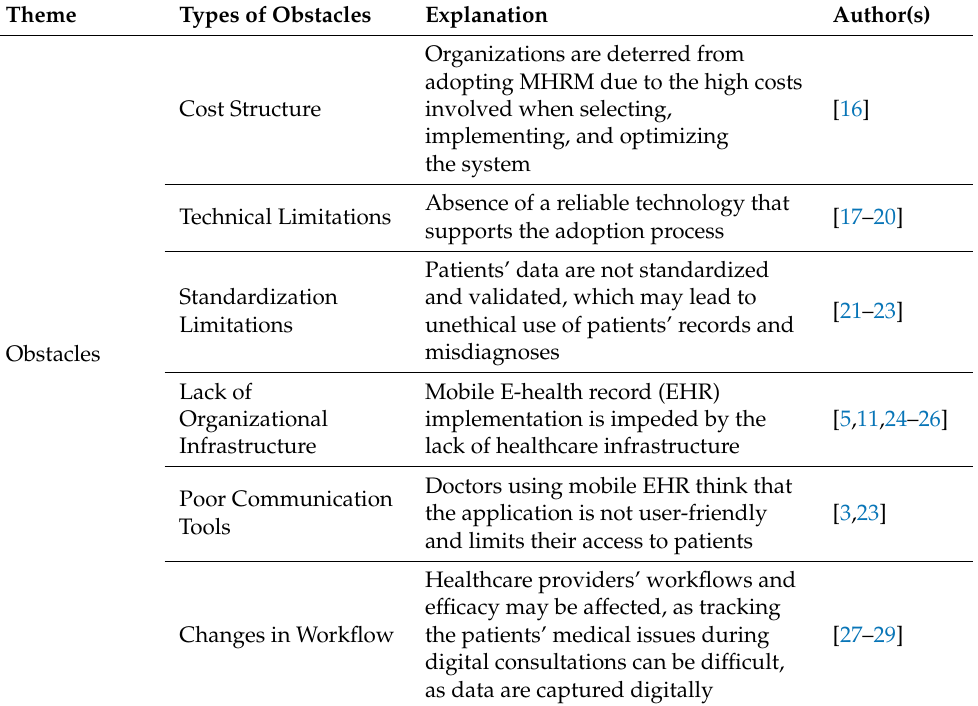
Table 2. Obstacles of Trust Elements in the MHRM management